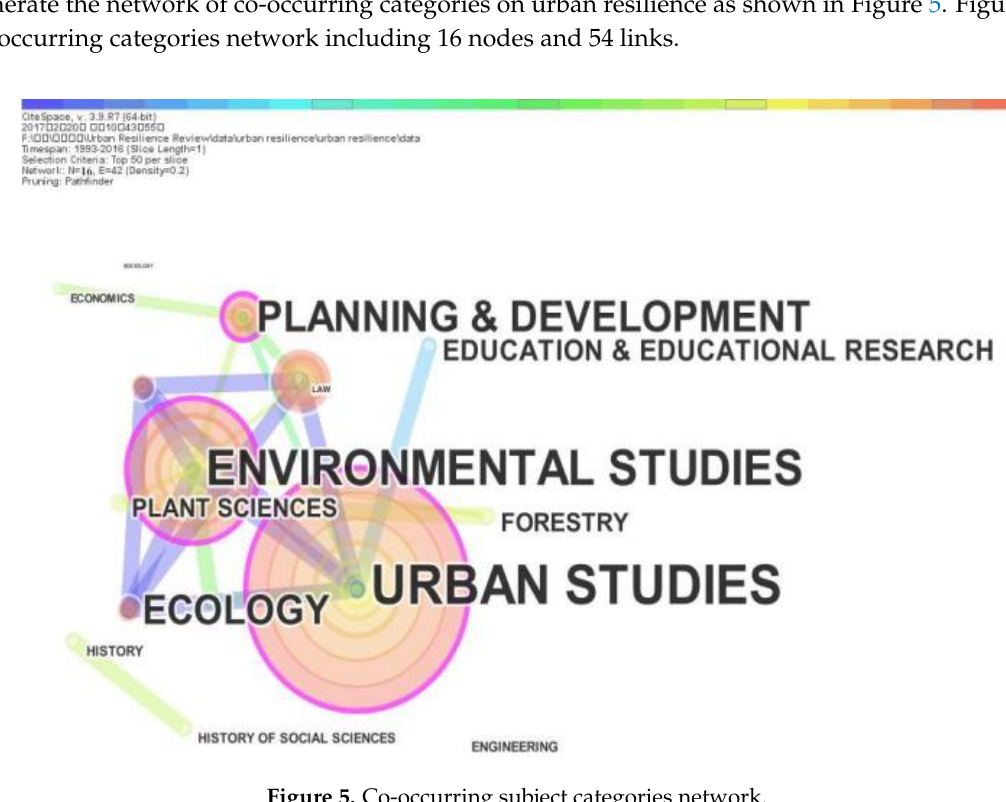
Figure 5. Co-occurring subject categories network.